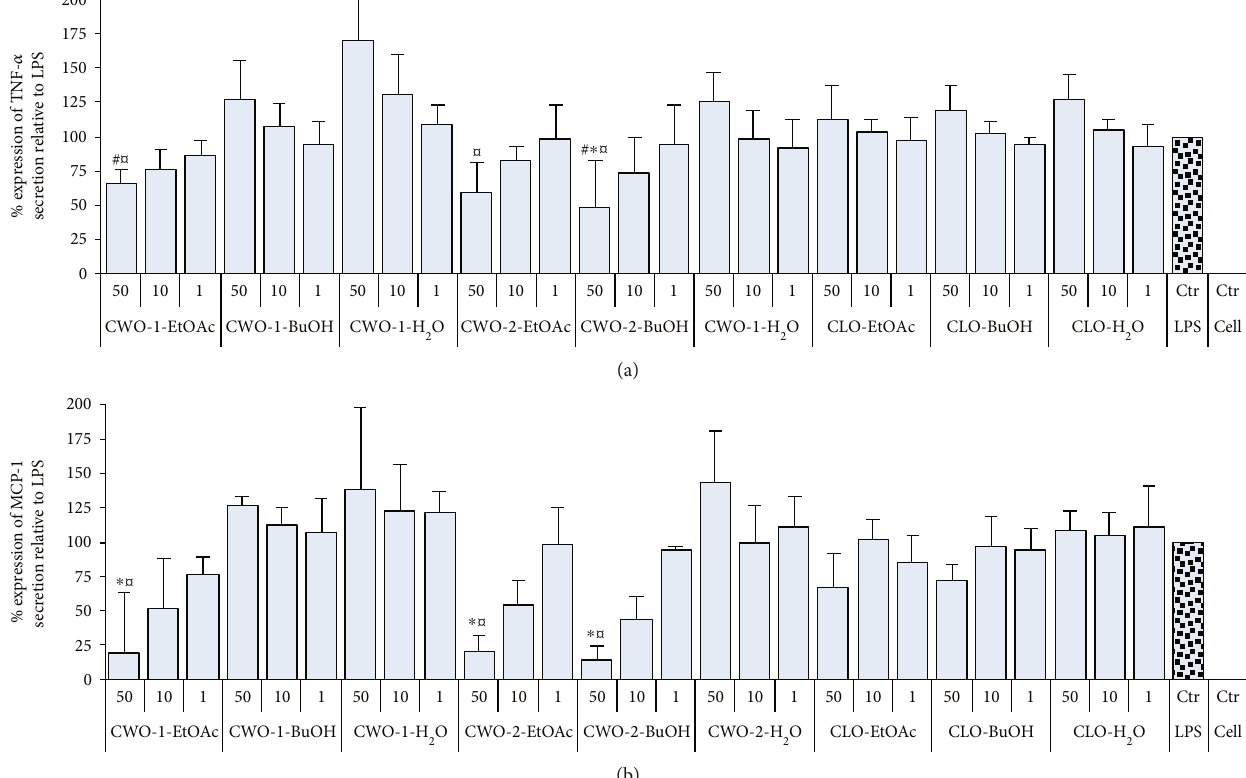
Figure 3: ELISA results for relative response of TNF- α and MCP-1 in LPS-treated THP-1 cells. Each extract was tested at three di ff erent concentrations (50 μ g/ml, 10 μ g/ml, and 1 μ g/ml), and the results are presented as mean with SD displayed as positive bars ( n = 3 ). (a) TNF- α secretion relative to control. ∗ p < 0 05 compared to LPS control. # p < 0 05 compared to CLO-BuOH 50 μ g/ml. ¤ p < 0 05 O 50 μ g/ml. (b) MCP-1 secretion relative to control. ∗ p < 0 001 compared to LPS control. ¤ p < 0 001 compared compared to CLO-H 2 to CLO-H O 50 μ g/ml. TNF- α =tumor necrosis factor-alpha; MCP-1=monocyte chemoattractant protein-1; LPS=lipopolysaccharide; 2 CWO=cold-pressed whale oil; CLO=cod liver oil; EtOAc=ethyl acetate; BuOH=butyl